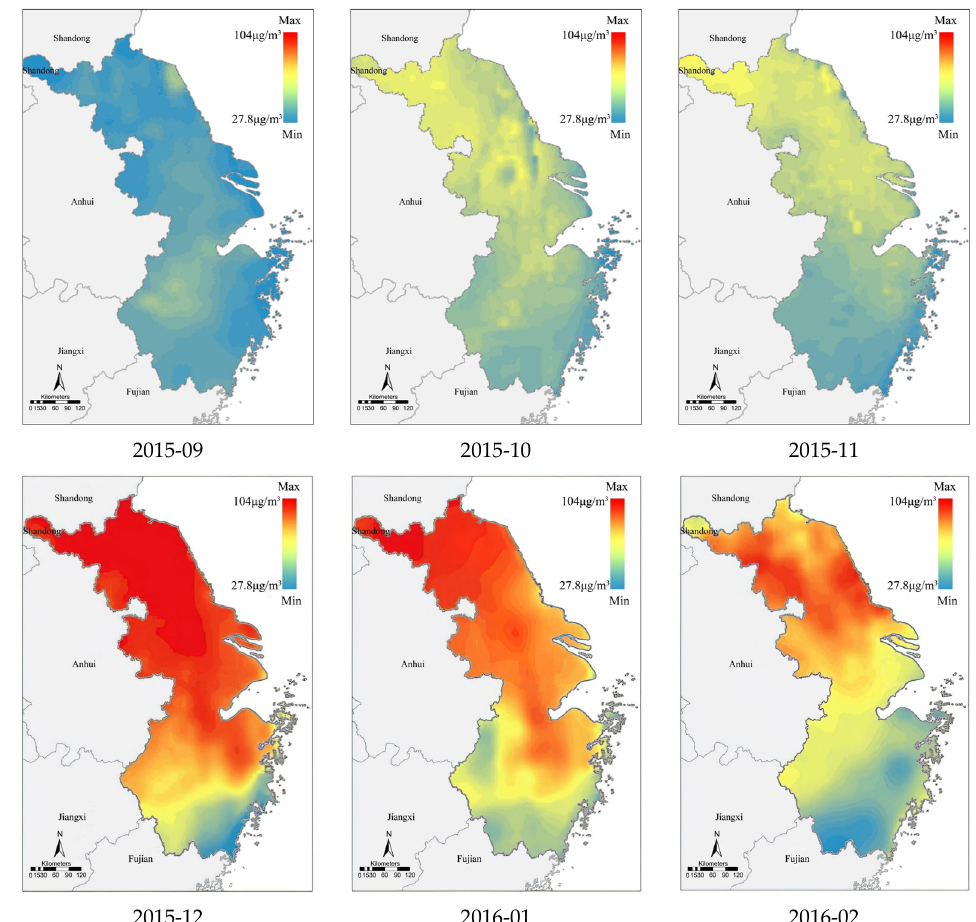
Figure 12. Monthly PM 2.5 concentration in the research area (GDWR 2015/03–2016/02).